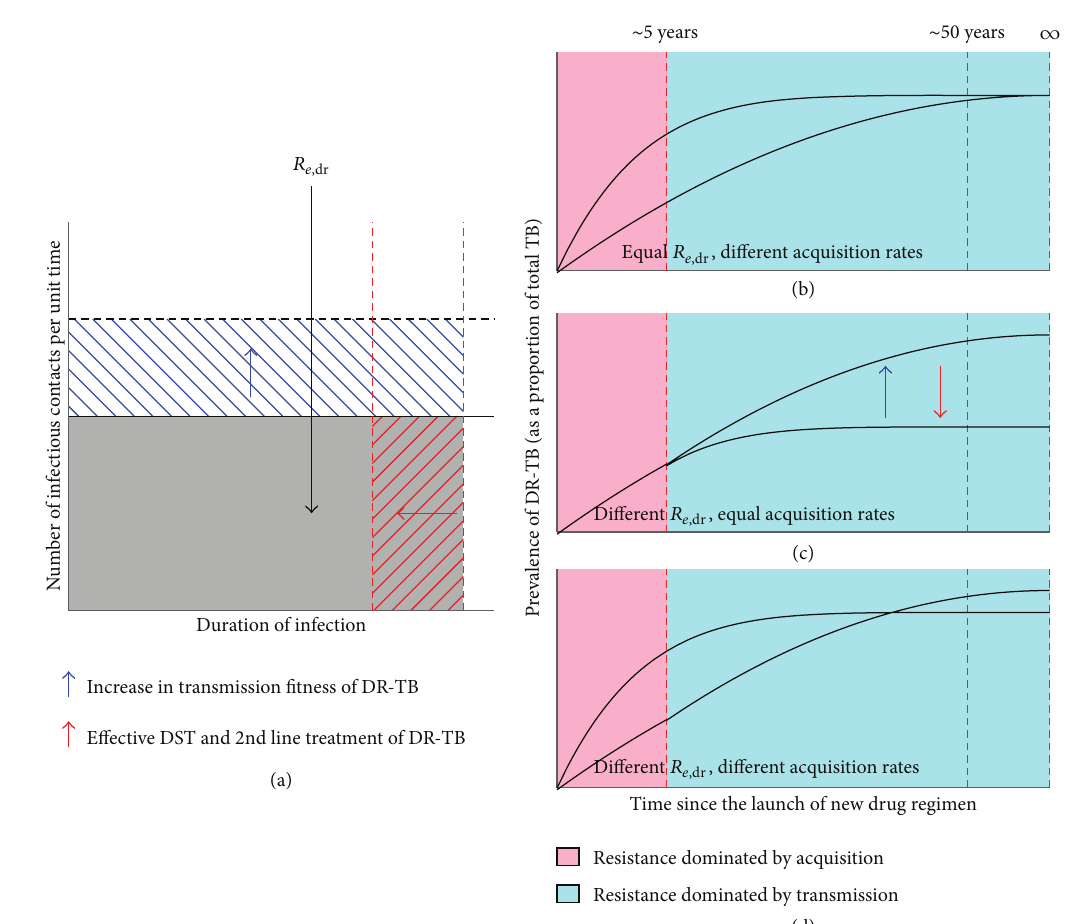
Figure 4: Proliferation of drug resistance following the launch of new first-line drug regimen. (a) The effective reproductive ratio of DR- ) is the expected number of secondary cases of active, resistant TB resulting from a single case of DR-TB (shown as the grey shaded TB ( 𝑅 𝑒, dr area). An increase in the relative transmission fitness of DR-TB (e.g., due to compensatory mutations; shown by the blue arrow) increases 𝑅 𝑒, dr (shown by the blue hatched area). Shortening the average duration of DR-TB infections (e.g., by deployment of DST, and effective second-line (shown by the red hatched area). However, the rate of acquisition of drug resistance (e.g., treatment; shown by the red arrow) decreases 𝑅 𝑒, dr (b, c, and d). The trajectories due to de novo mutations against drugs in the treatment regimen) does not factor in the calculation of 𝑅 𝑒, dr of the prevalence of DR-TB just following the launch of a hypothetical new drug regimen are affected by both the acquisition rates and the 𝑅 𝑒, dr of DR-TB, but their effects will be more pronounced at different time periods. Acquisition-driven drug resistance is expected to be more frequent in the first 5 years (pink area), while transmission-driven TB relatively later (blue area). (b) For two hypothetical DR-TB strains with , but different acquisition rates, we may observe difference in their prevalence in the short term, but over time they are expected to similar 𝑅 𝑒, dr , we may not observe significant result in similar levels of resistance. (c) In contrast, for strains with similar acquisition rates, but different 𝑅 𝑒, dr will affect the difference in their prevalence in the short term, but the levels of drug resistance can diverge significantly. Factors that affect 𝑅 𝑒, dr trajectories of DR-TB prevalence—for example, deployment of DST that achieve reduction in average duration of infection (red arrow) can is expected to be more prevalent reduce prevalence of DR-TB over longer term. (d) DR-TB strain with larger acquisition rate and smaller 𝑅 𝑒, dr , but the prevalence of DR-TB is flipped between two over the short term compared to a strain with lower acquisition rate and higher 𝑅 𝑒, dr hypothetical strains over longer term. Hence, short term prevalence of DR-TB alone may not be a reliable predictor of the prevalence over longer term. Figures are only illustrative and not drawn to